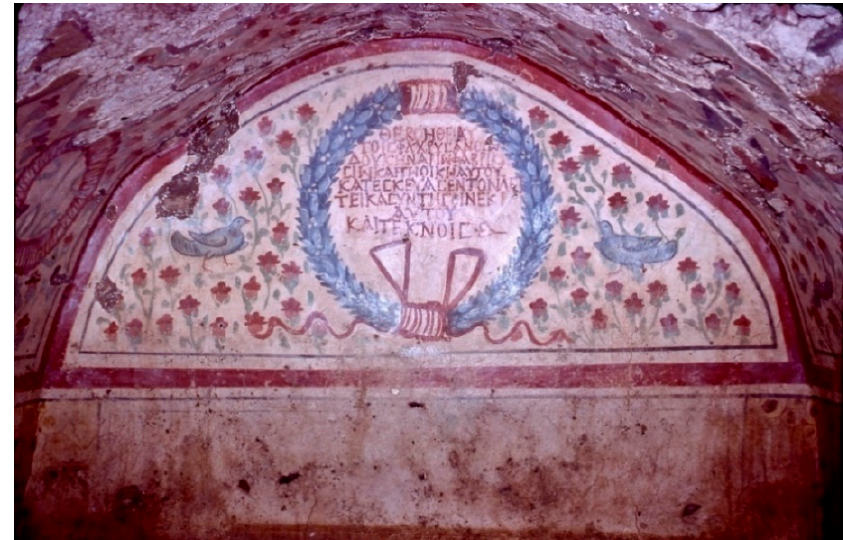
Figure 6. Sardis, Tomb of Chrysanthios (Tomb 76.1, Appendix A.1), south wall. © Archaeological Exploration of Sardis/President and fellows of Harvard College.